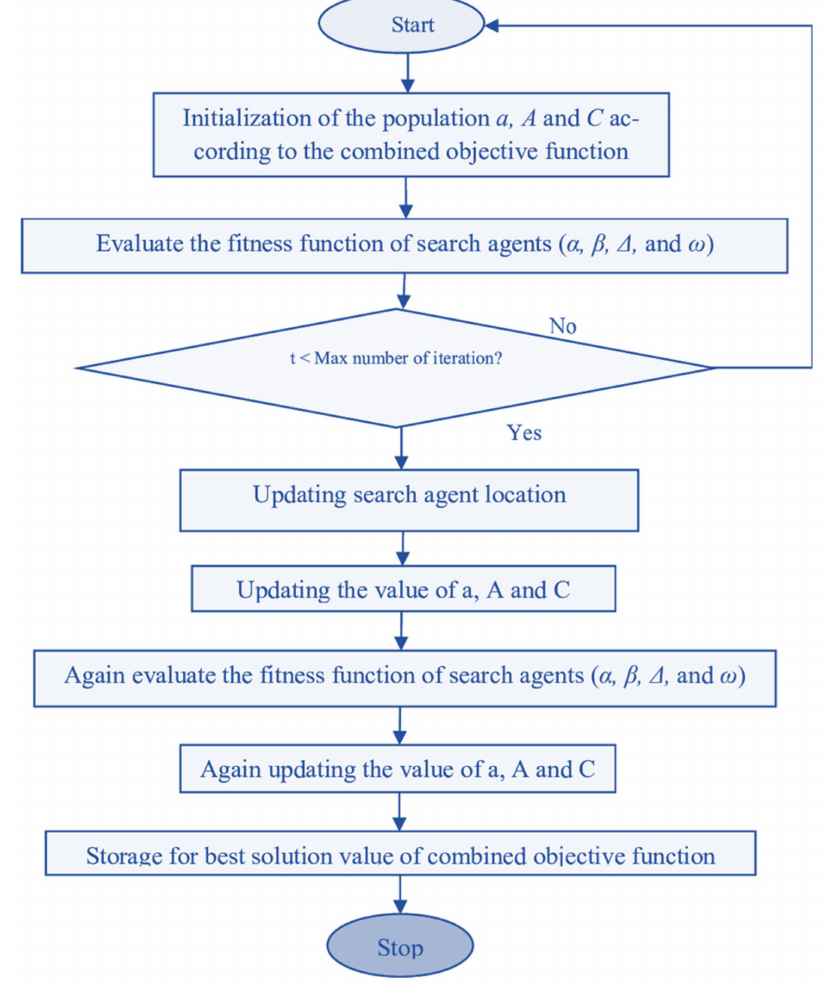
Figure 4. Flowchart of GWO optimization